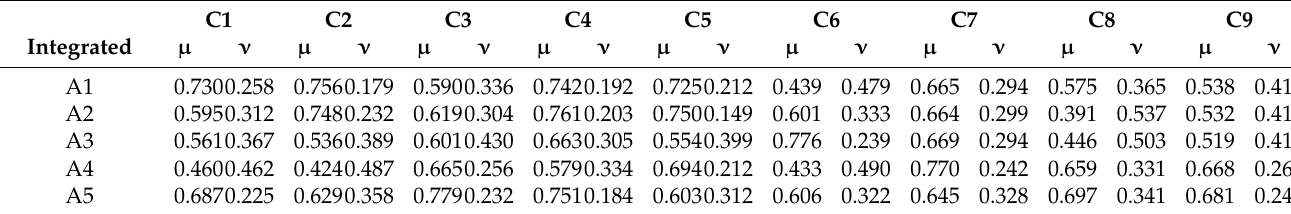
Table 10. The integrated decision matrix.